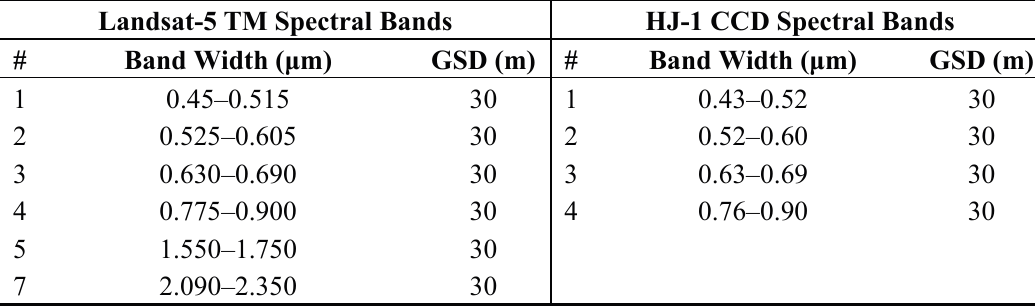
Table 1. Landsat-5 TM and HJ-1 CCD spectral bands.